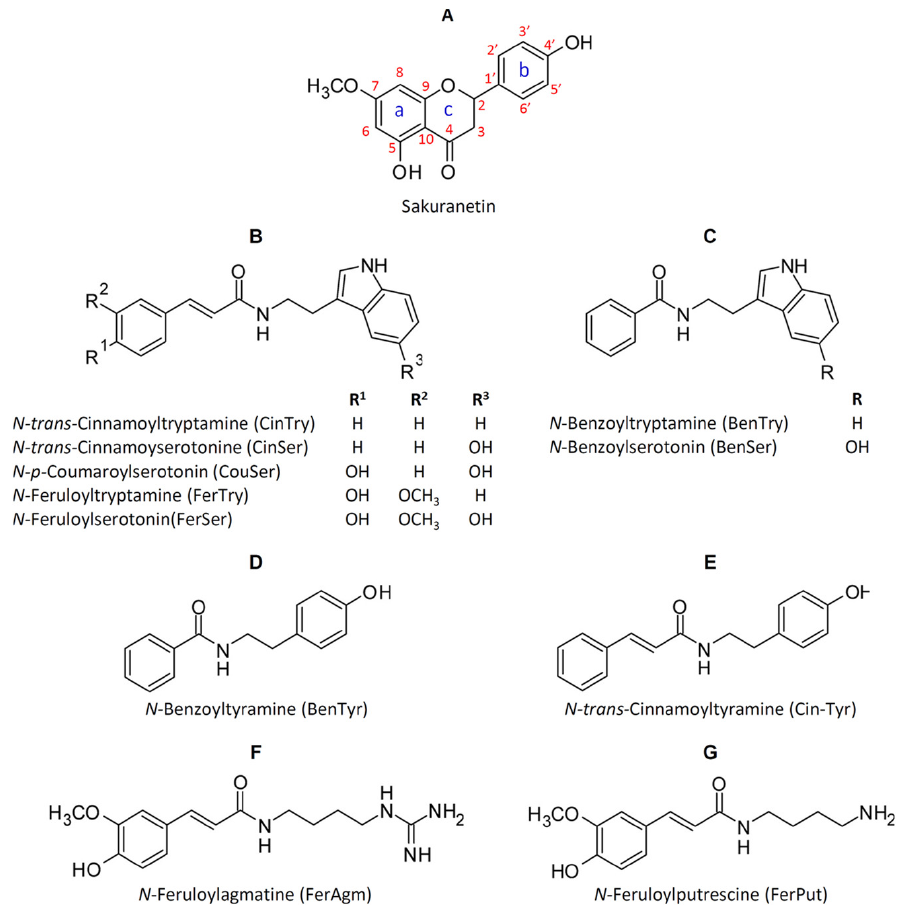
Figure 4. Phenolic compounds that accumulate in rice after exposure to biotic and/or abiotic stresses. ( A ) is a flavanone compound, while ( B – G ) are phenylamides.